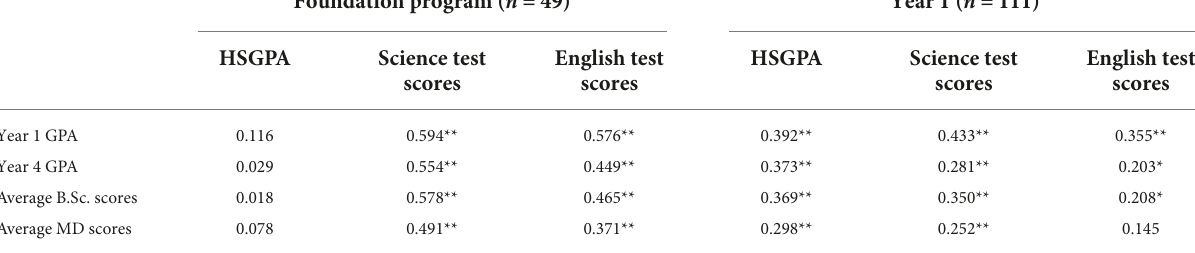
TABLE 3 Pearson correlation coefficients for predictor variables and academic performance (outcome indicators) according to admission types (foundation program and year 1 admission).